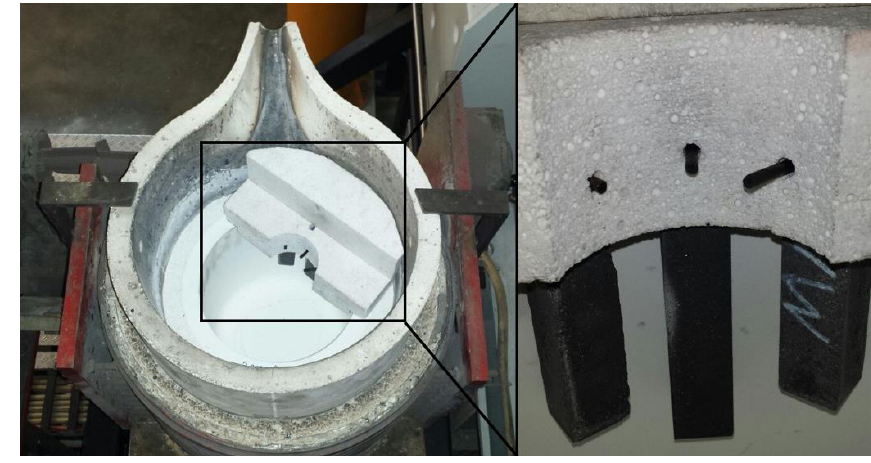
Figure 1. Equipment for corrosion test of samples.